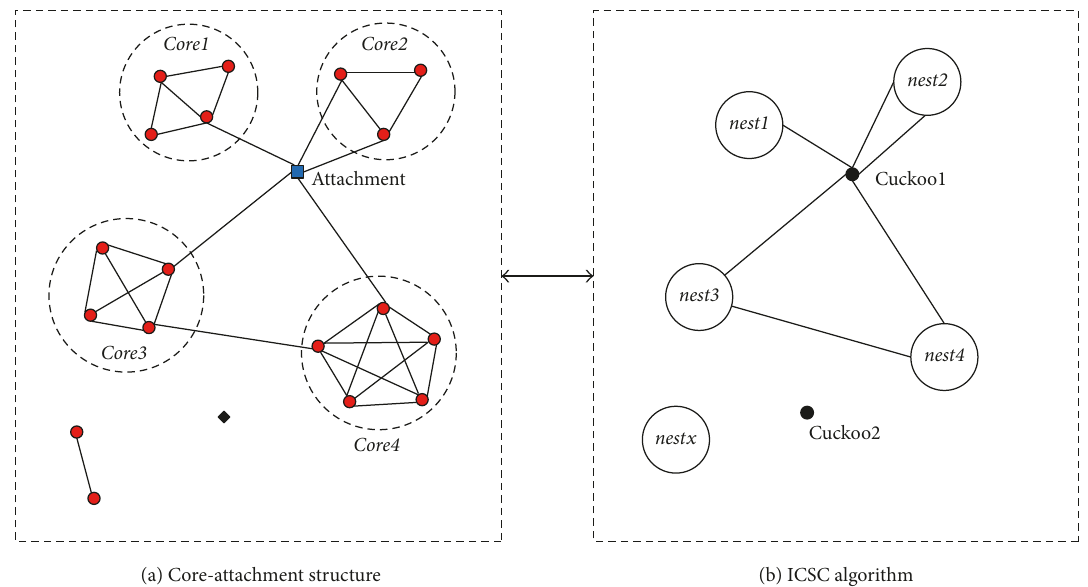
Figure 2: The corresponding relationships between ICSC algorithm and the clustering procedure of a PPI network.